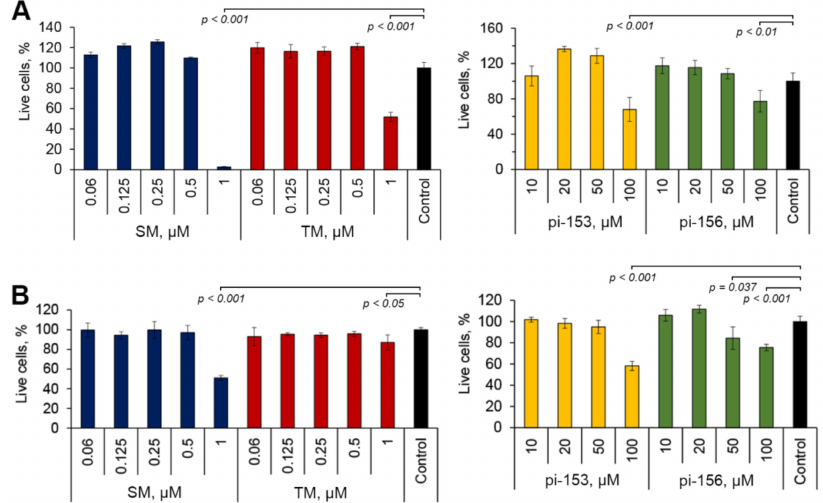
Figure 2. Cytotoxicity of cyano enone-containing semisynthetic triterpenoids (SM, TM) and steroids (pi-153, pi-156) with respect to murine melanoma B16 ( A ) and human lung adenocarcinoma A549 ( B ) cells. The cells were treated with mentioned compounds for 48 h followed by the measurement of cell viability by 3-(4, 5-dimethylthiazol-2-yl)-2, 5-diphenyltetrazolium bromide (MTT) assay. Error bars represent the standard deviation of three independent experiments performed in